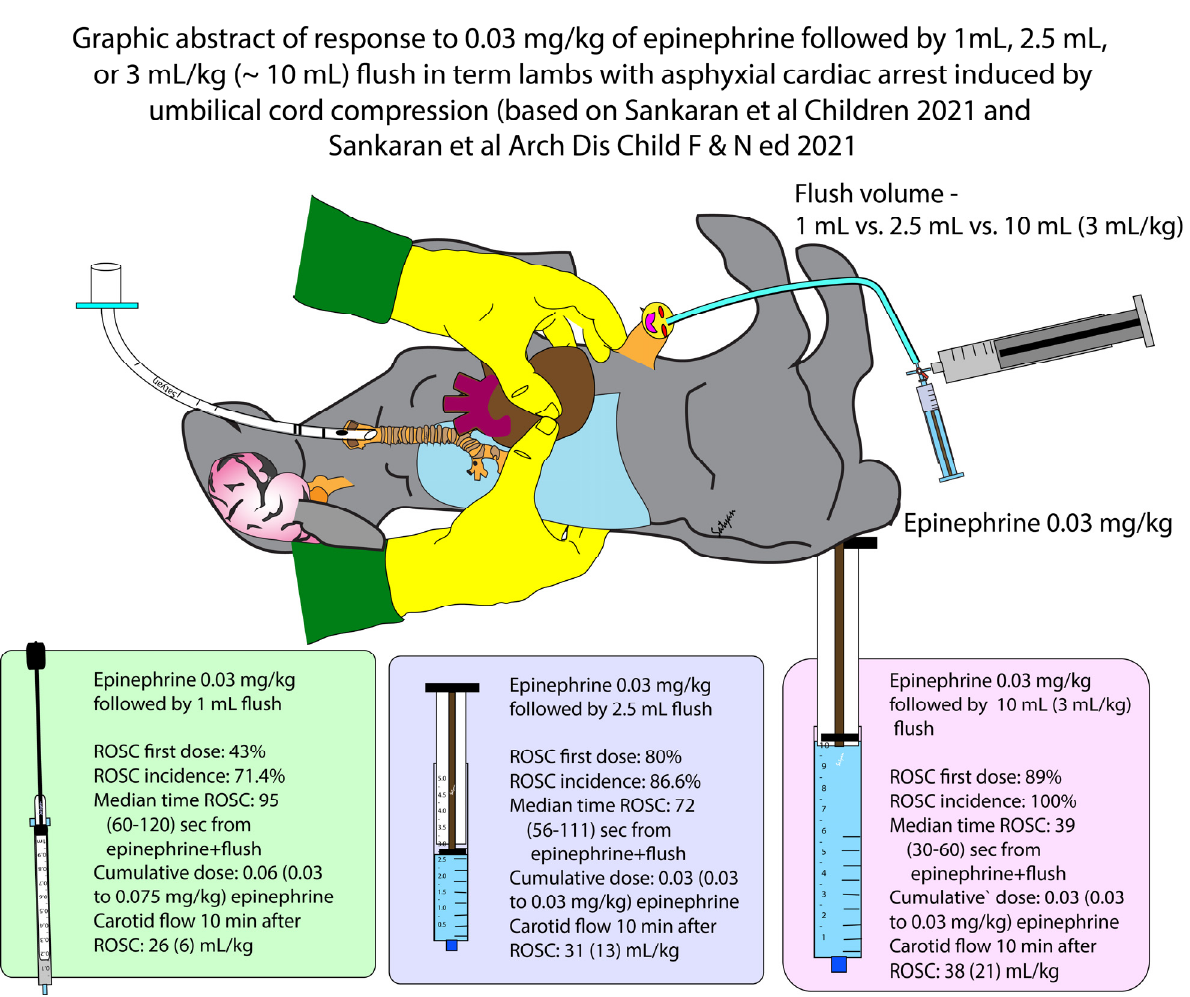
Figure 2. Graphic abstract of data from current study and Sankaran et al. [12] comparing 1-mL, 2.5-mL, and 3 mL/kg (~10 mL) flush in term lambs with asphyxial arrest induced by umbilical cord occlusion. In lambs receiving 10-mL flush, only the first dose of epinephrine was associated with high volume flush. (Copyright Satyan Lakshminrusimha).